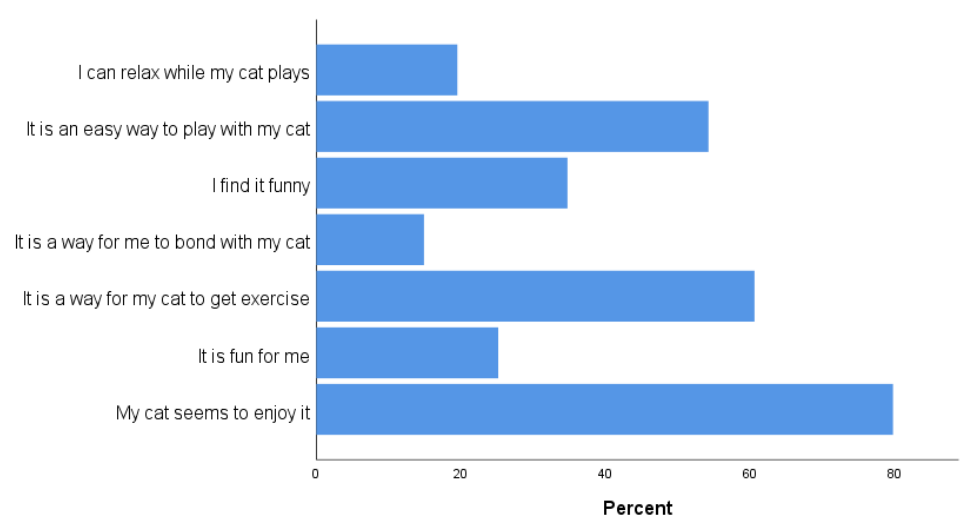
Figure 4. Reasons given by cat guardians for not currently (or ever) using laser light pointers to play with their cats ( n = 336).